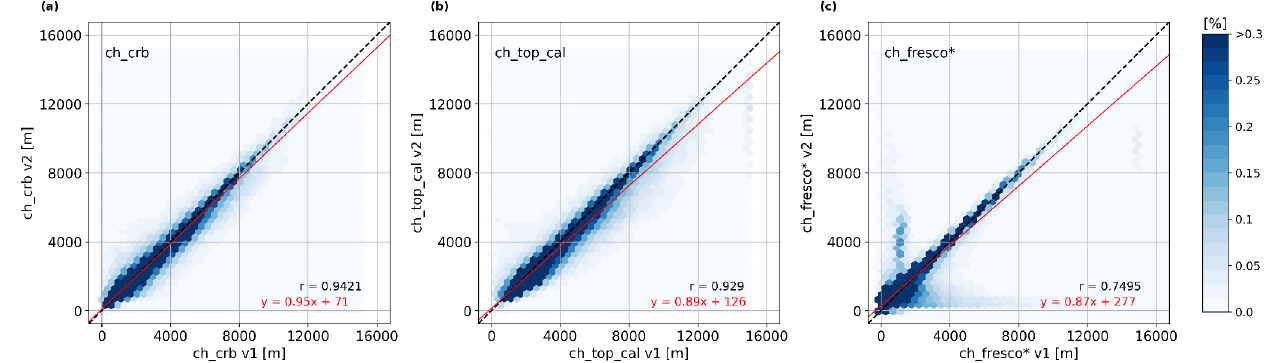
Figure 4. Density histograms between the version 1 and version 2 cloud heights from (a) ROCINN CRB, (b) ROCINN CAL top, and